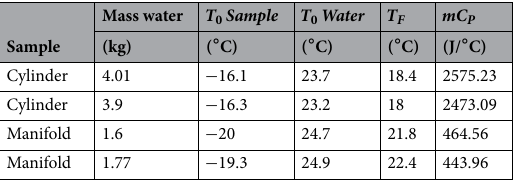
Table 3. The results of the effort to find the mass heat capacity mC P (J/